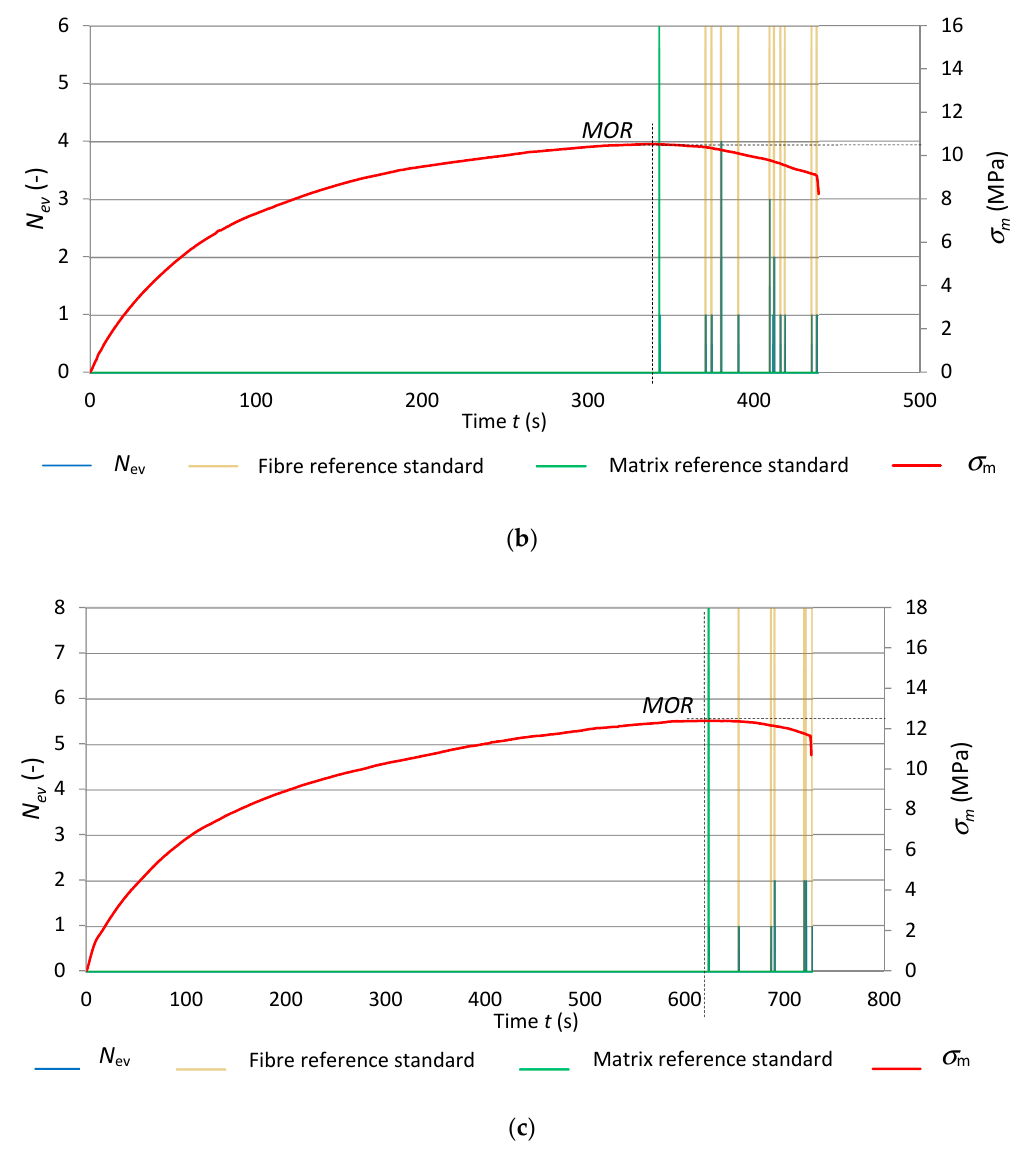
Figure 10. Freeze–thaw cycling diagrams of events rate N ev and bending stress σ m versus time, with superimposed identified reference spectral characteristics: ( a ) series A R , ( b ) series A 1 , ( c ) series A 10 .